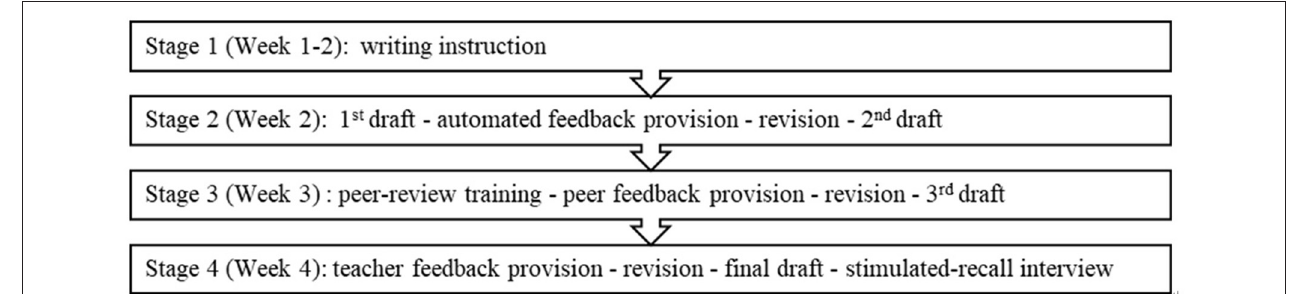
FIGURE 1 | Data collection procedures for each